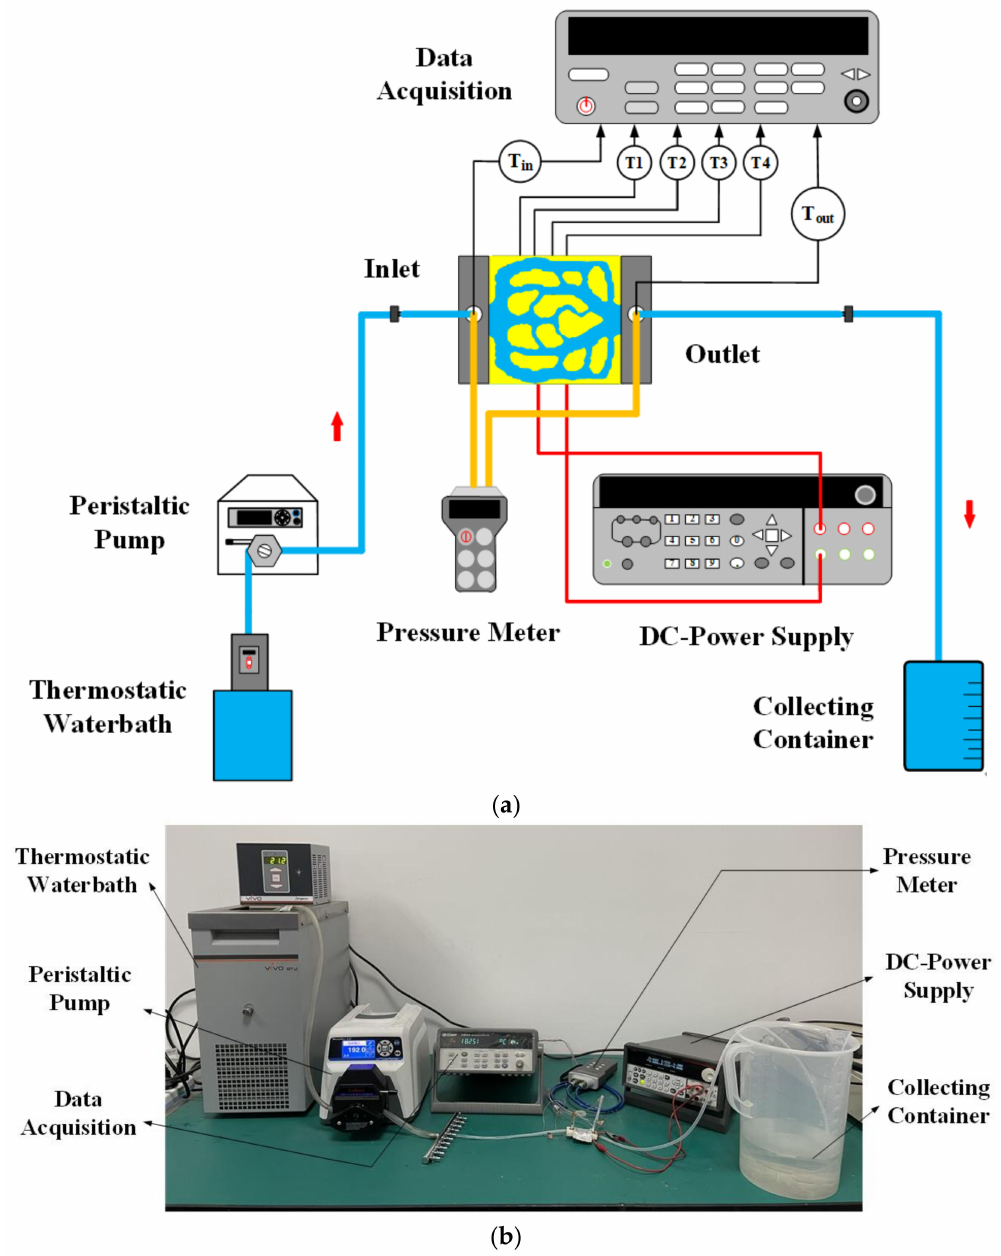
Figure 17. Verification device of numerical simulation results. ( a ) Experimental schematic diagram; ( b ) Experimental test